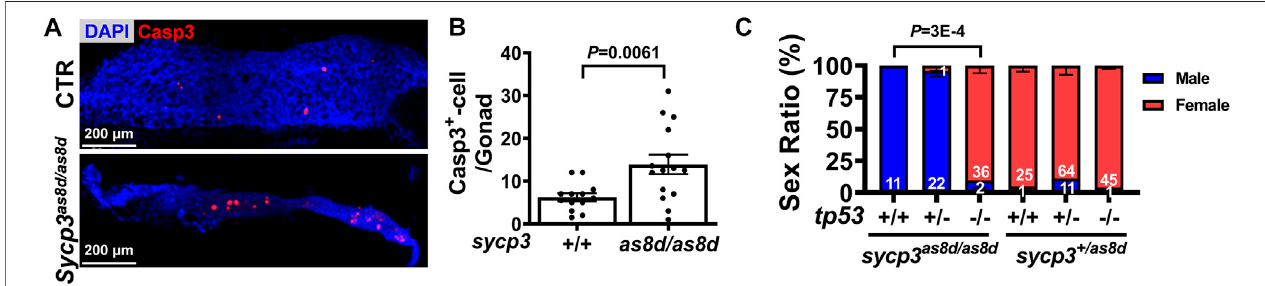
FIGURE4| Thesexreversalofsycp3mutant fi shiscausedbygermcellapoptosisandcanbecompensatedbyadditionaltp53mutation. (A) .Theimmunostaining of apoptotic marker Caspase-3 (Wilson, High et al.). DAPI staining is blue for nuclei. (B) . Quanti fi cation results of Caspase-3. Apoptotic germ cells are increased in the 1 month old sycp3 as8d/as8d gonad. (C) . The sex ratios of tp53 -/ - ; sycp3 as8d/as8d mutants. While sycp3 as8d/as8d fi sh are all males, many females have the tp53 -/- ; sycp3 as8d/as8d genotype. Blue bar represents males and the red bar represents